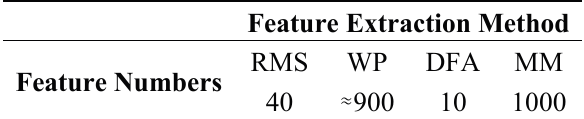
Table 1. Feature numbers for the four extraction